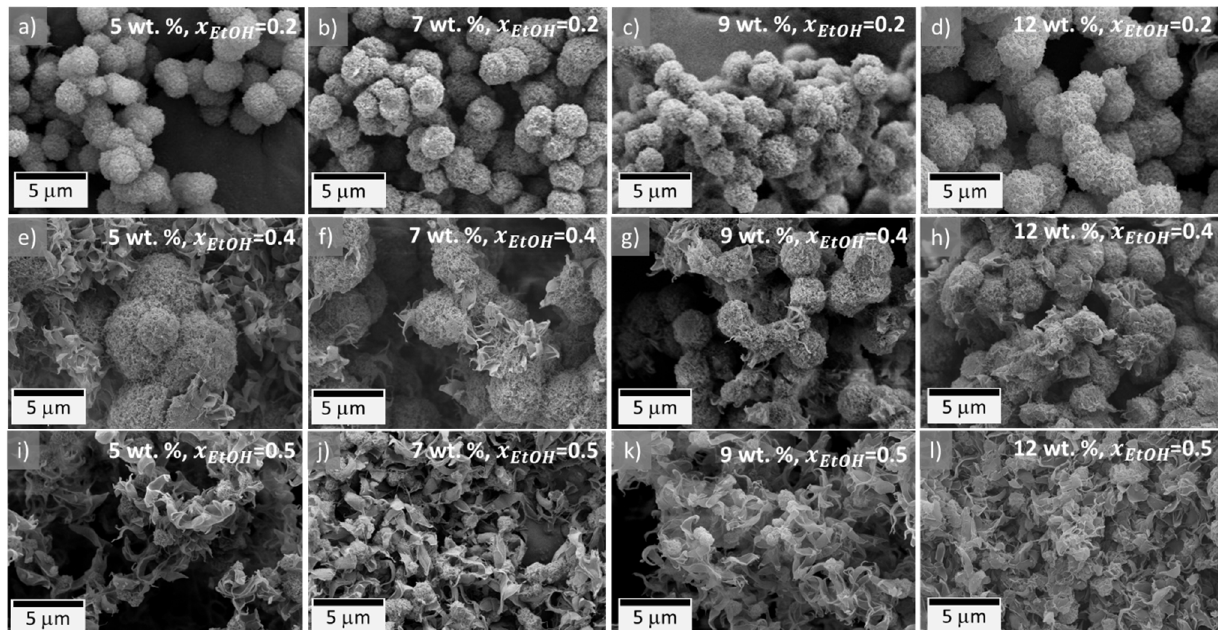
Figure 3. Microstructure of the as-obtained PVDF aerogels, using different DMF/ethanol blends; ( a –